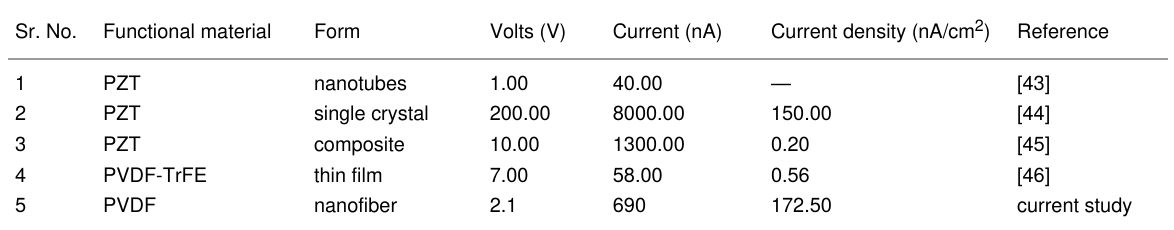
Table 1: Comparative study of the current density. Sr.